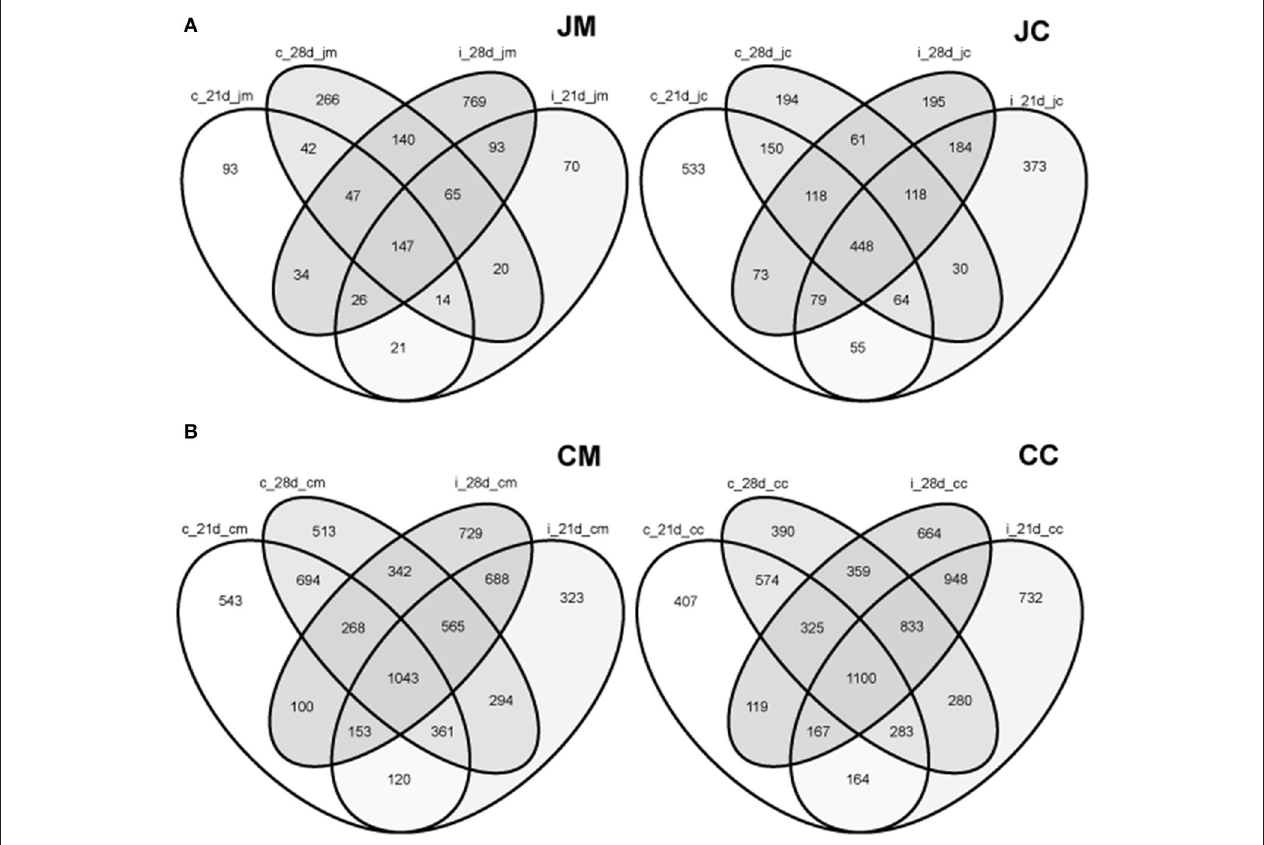
FIGURE 7 | Venn diagrams showing the shared OTUs between the control and infected birds at different gut sites at the two sampling points post infection (A) jejunum; (B) cecum. JM, jejunal mucosa; JC, jejunal content; CM, cecum mucosa; CC, cecum content; control (c); infected (i); d,